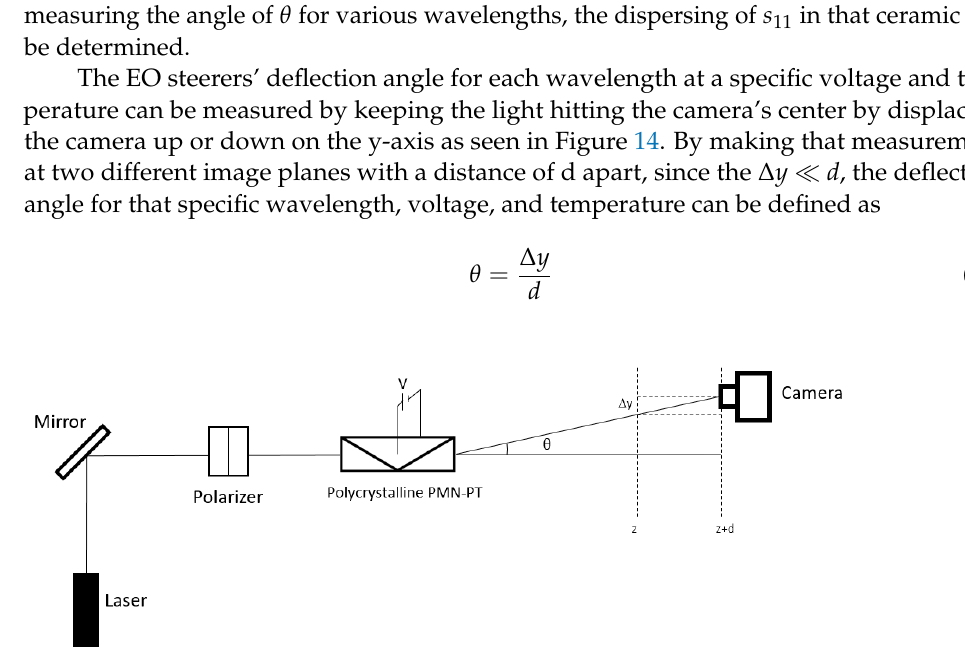
Figure 14. The experimental set-up for characterization of the EO beam steerer based on polycrys- talline PMN-PT.